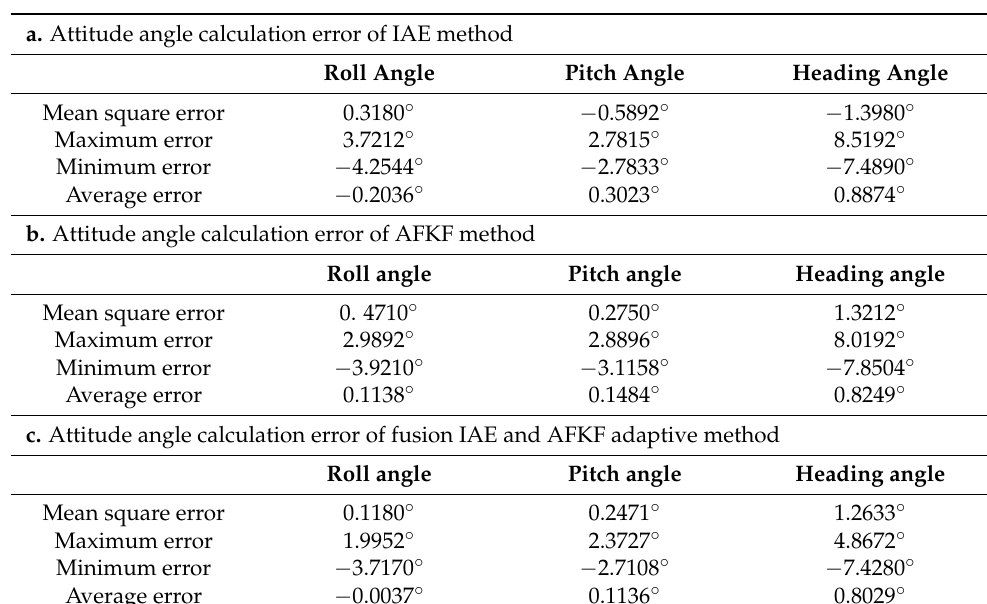
Figure 4. Attitude angle error of measured data. Table 2. Attitude angle calculation error.